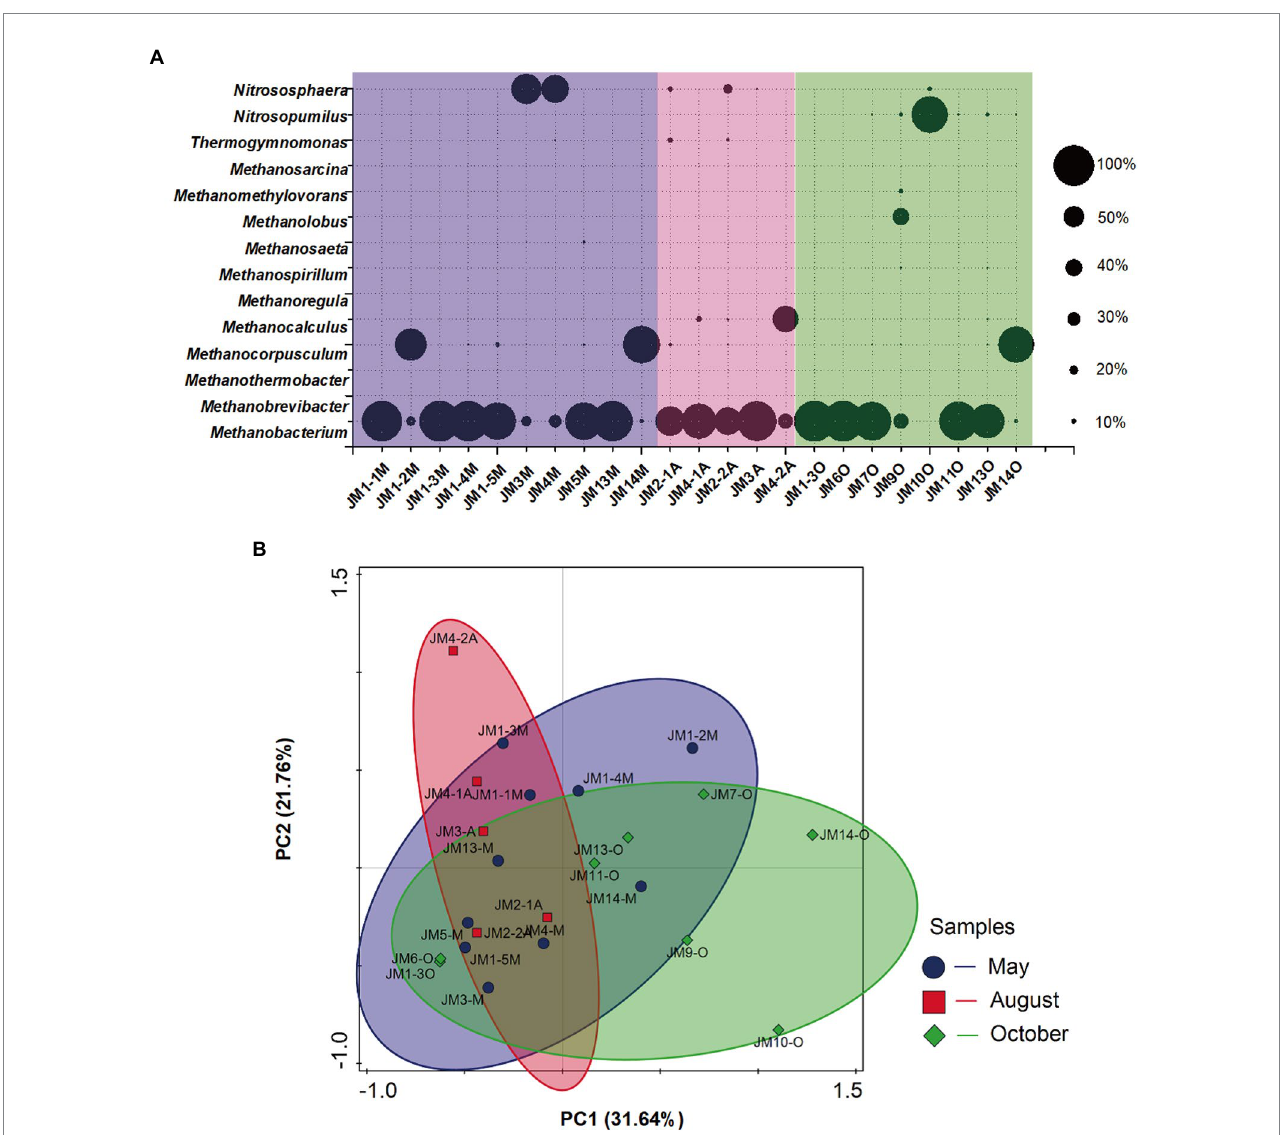
FIGURE 2 (A) Responses of archaeal community structure to seasonal variation in coalbed water based on 16S rRNA sequencing. The suffix letter of each sample name represents the month in which the sample was taken (M: May; A: August; O: October). The size of the bubble represents the relative abundance